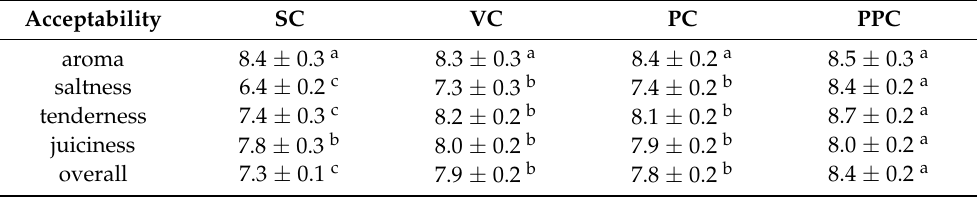
Values in the same row followed by different letters differed significantly ( p < 0.05). SC = static curing, VC = vacuum curing, PC = pressurized curing, PPC = pulsed pressure